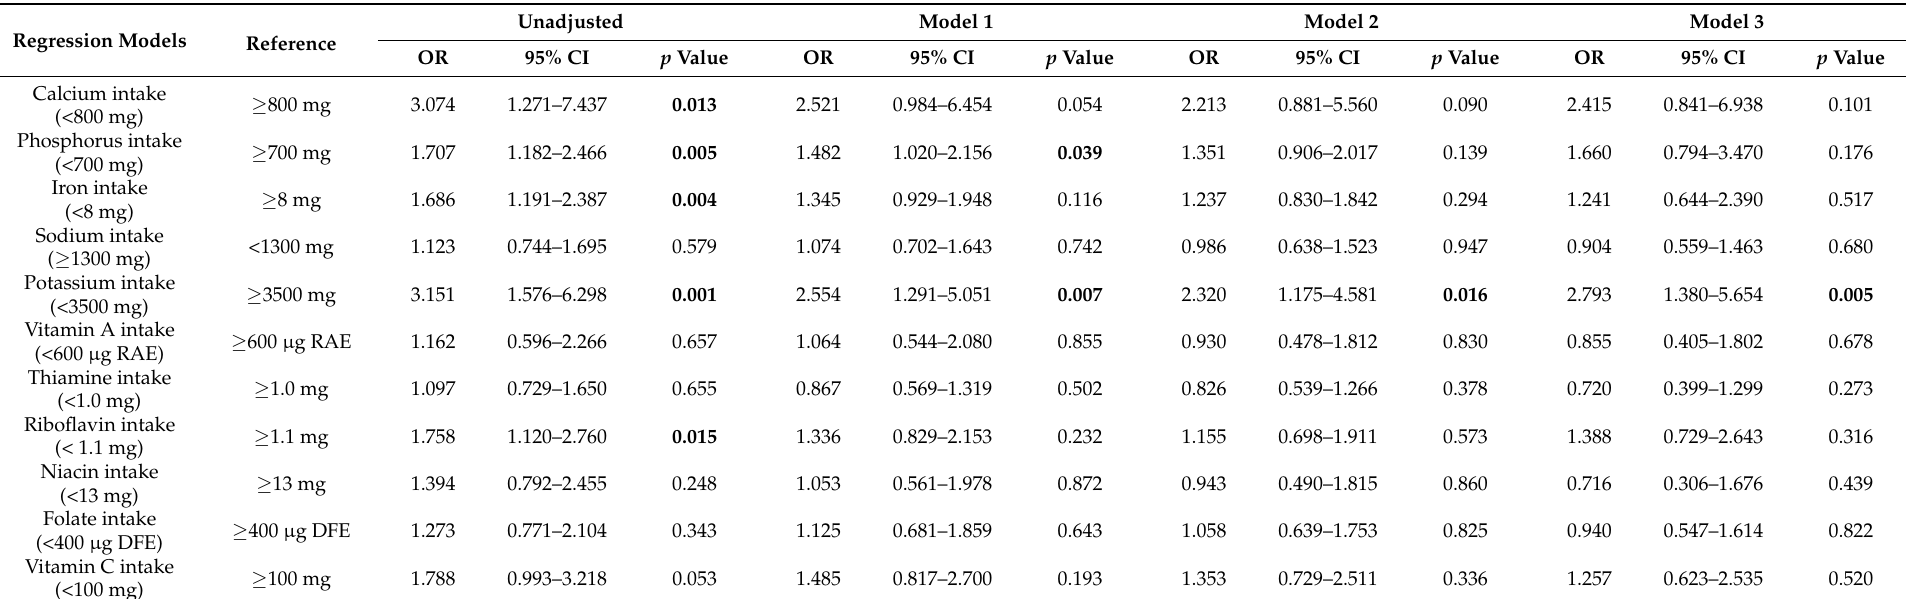
Table 4. Multiple logistic regression for low handgrip strength in women aged ≥ 65